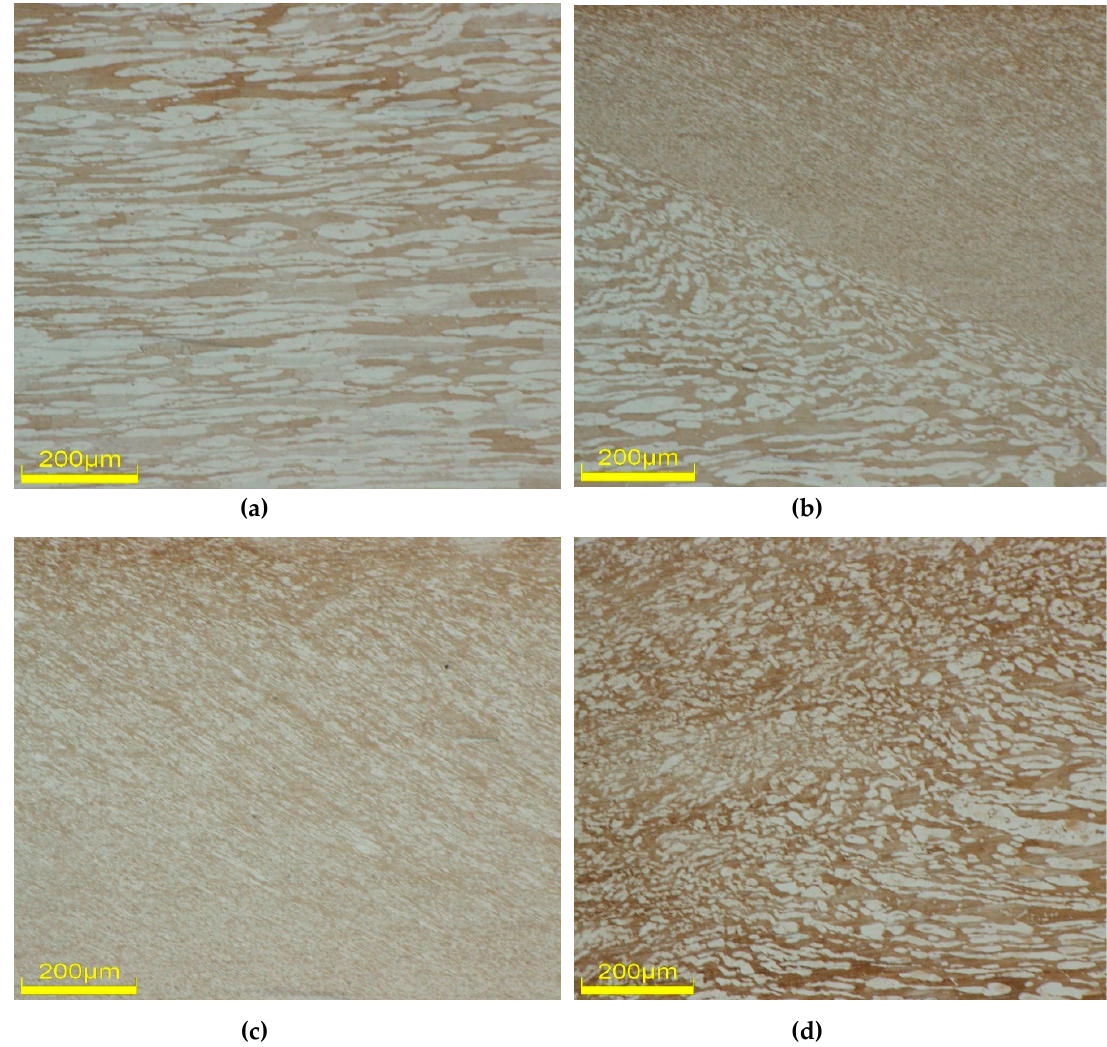
Figure 9. Microstructure of processed material ( a ) BM, ( b ) boundary of TMAZ-AS, ( c ) SZ, and ( d ) boundary of TMAZ-RS.